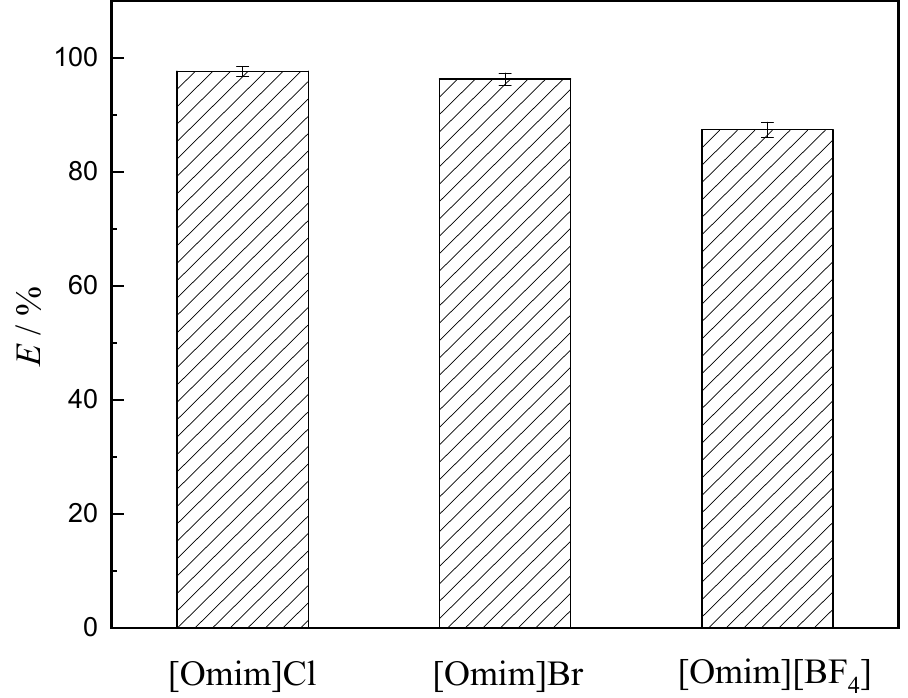
Figure 4. The extraction of V (V) by using the three ionic liquids (experimental conditions: concentration of V (V) in the aqueous phase 1.75 g · L − 1 , concentration of extractant 0.2 mol · L − 1 , aqueous phase pH 8.051, extraction temperature 25 °C, and equilibrium time 60 s).